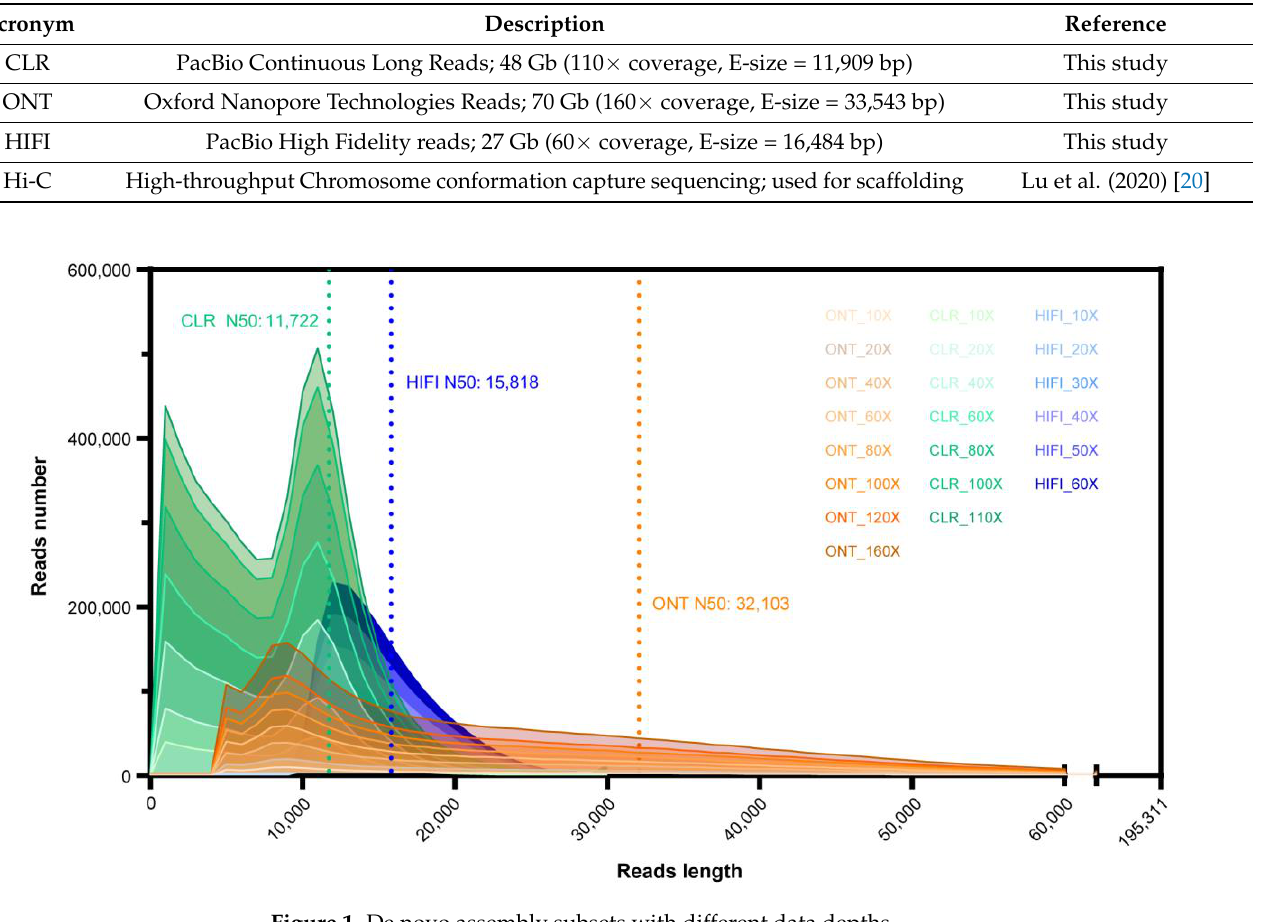
Figure 1. De novo assembly subsets with different data depths.